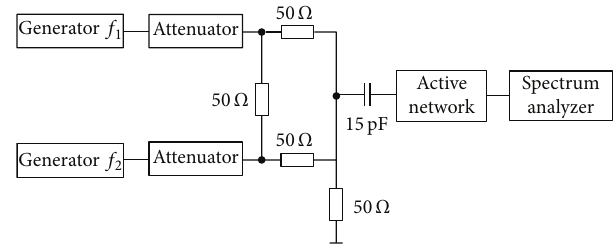
Figure 12: Intermodulation distortion measurement